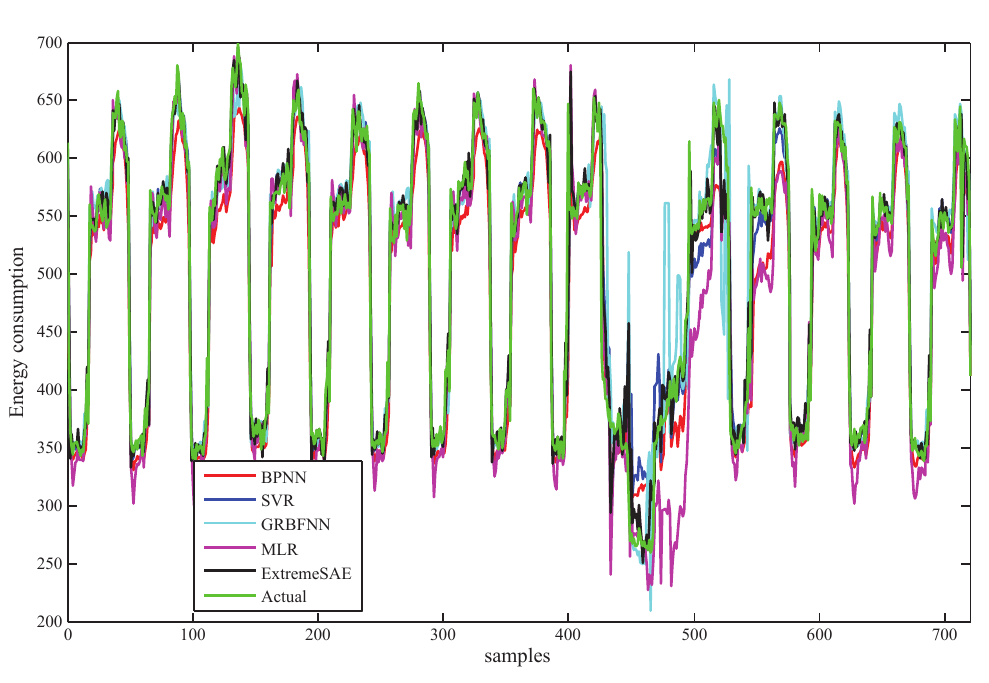
Figure 6. Prediction results of the five models in the 30 min